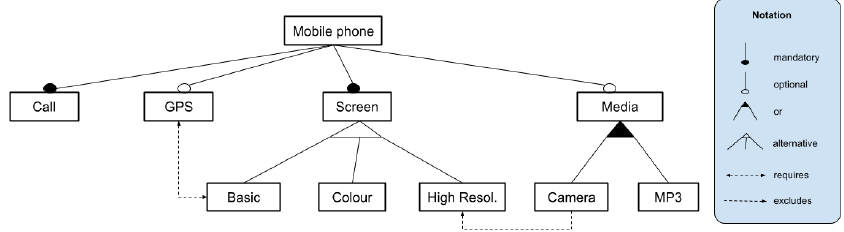
Figure 2. Example of an FM for a Mobile Phone SPL.